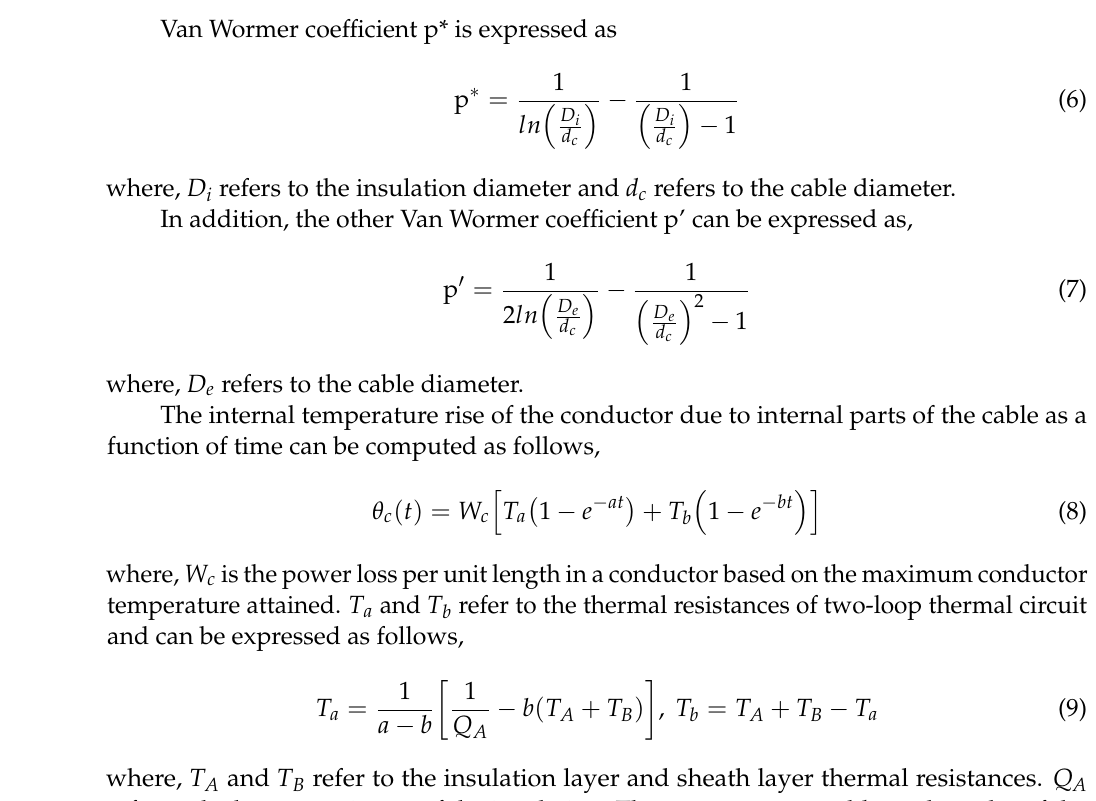
Figure 5. Thermal cable network for a short-duration transient.